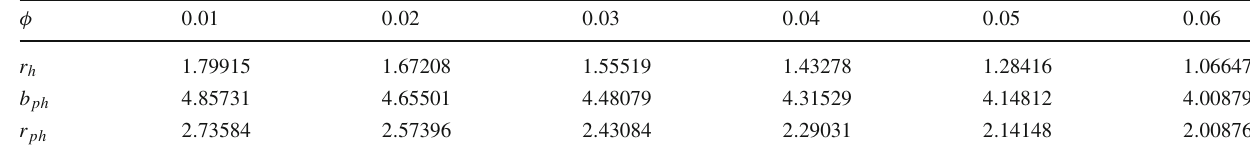
Table 1 The numerical values of r h , b ph , and r ph , for some specific values of φ with λ = 0 . 1, Q = 0 . 1 and M = 1 φ 0 . 01 0 . 02